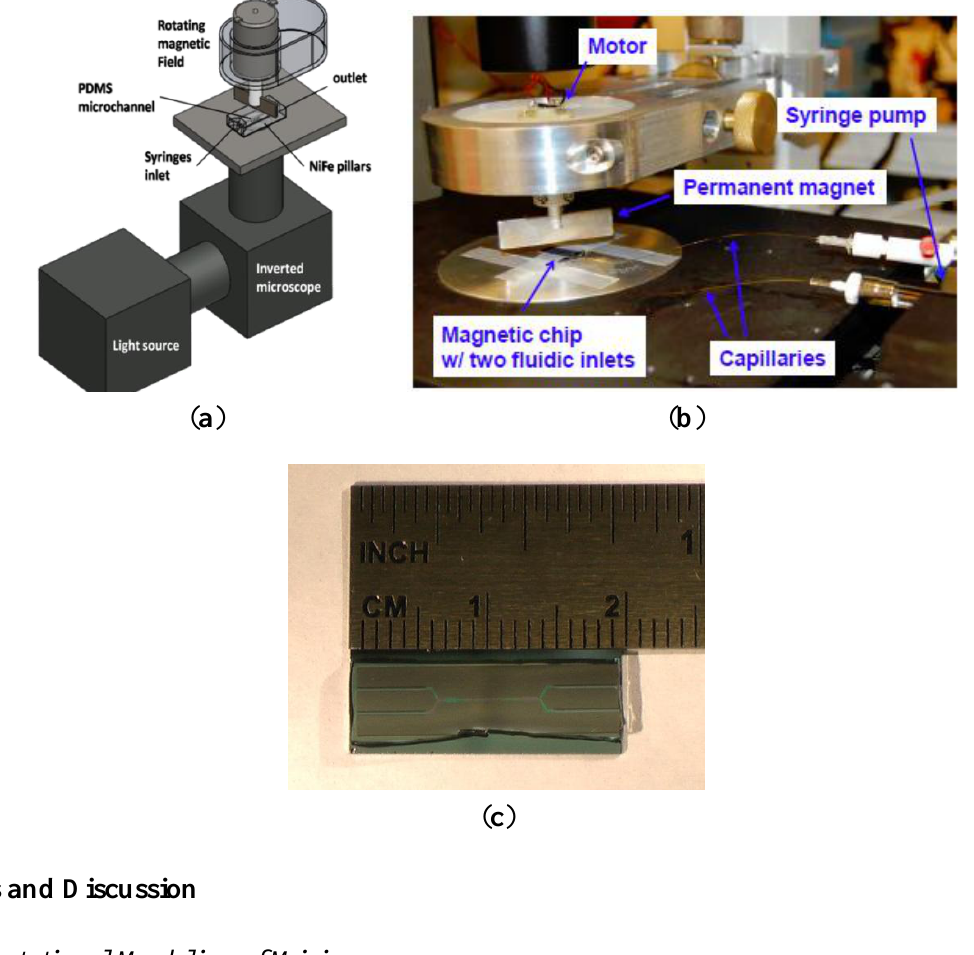
Figure 3 Images of experimental set-up. Bottom image shows assembled PDMS channel with two inlets and two outlets and chip with NiFe